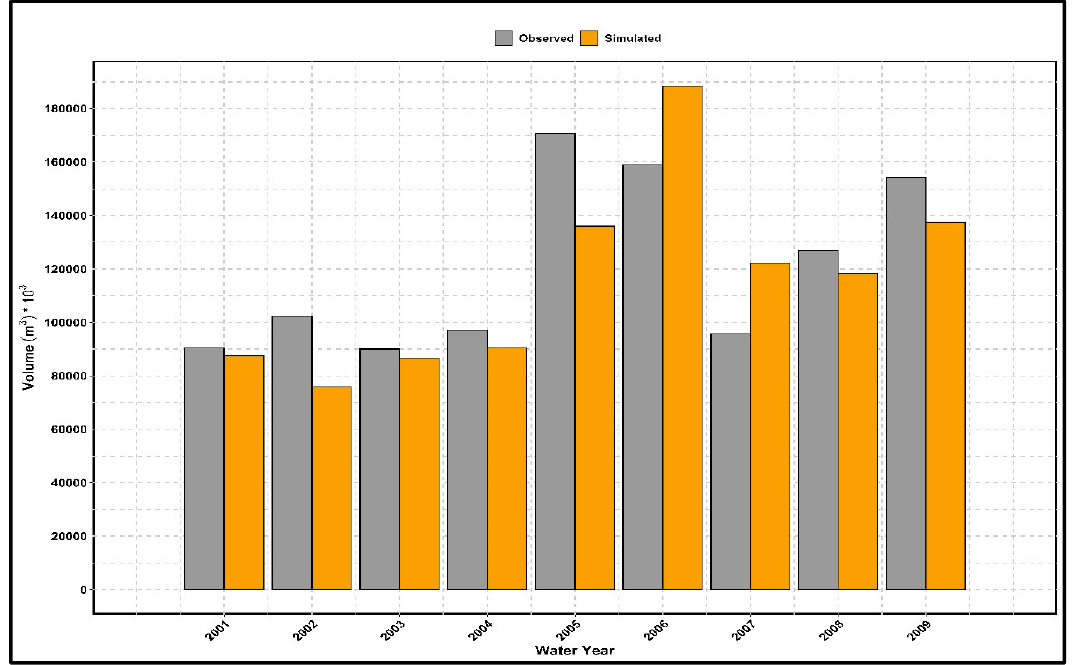
ff for the Jordan River